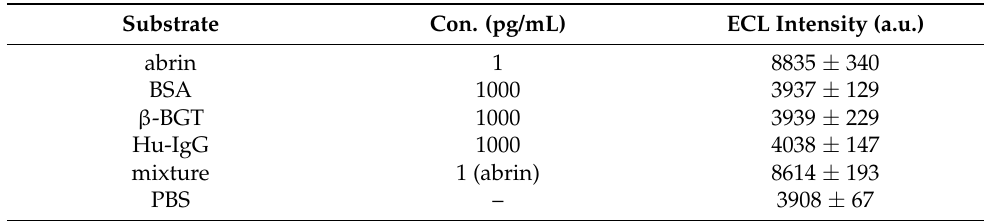
Table 2. Specificity test ( n = 5).